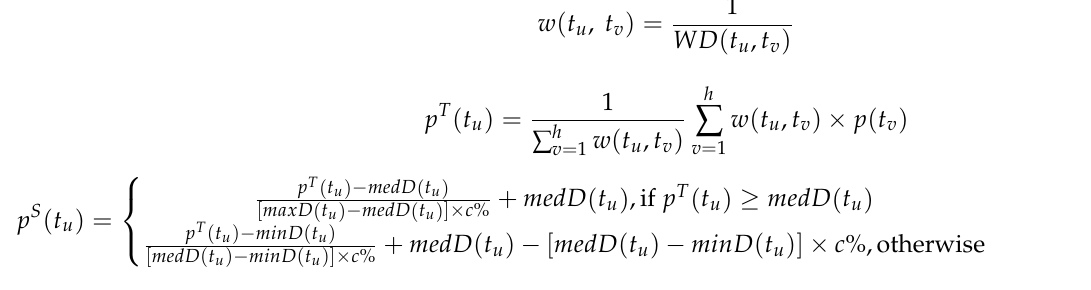
Figure 5. Schematic diagram of the forecasting approach.